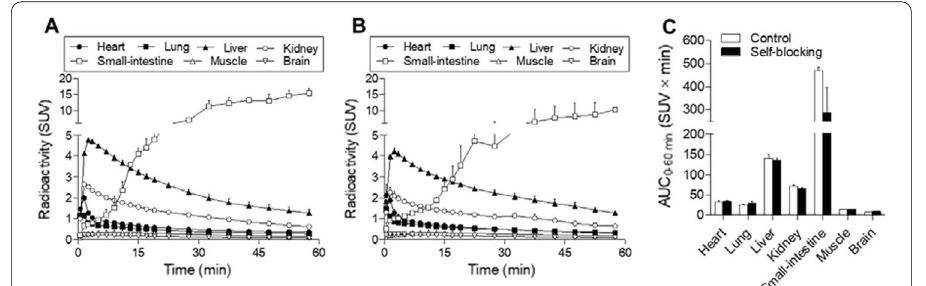
Fig. 4 Time–activity curves (n 2, in each group) of [ 11 C]PK68 in the heart (buried circles), lung (buried = squares), liver (buried triangles), kidney (open circles), muscle (open squares), and brain (open triangles) of mice treated without ( A ) or with unlabeled PK68 (1 mg/kg, i.v., B ) and areas under the curves ( c ) in these tissues. Radioactivity is expressed as standardized uptake values (SUVs)